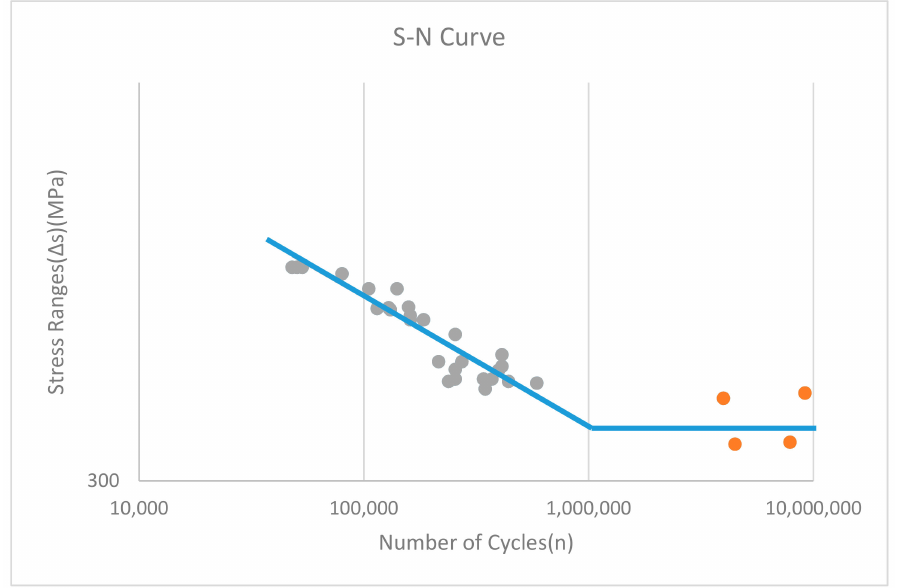
Figure 1. S-N curve for rebar data